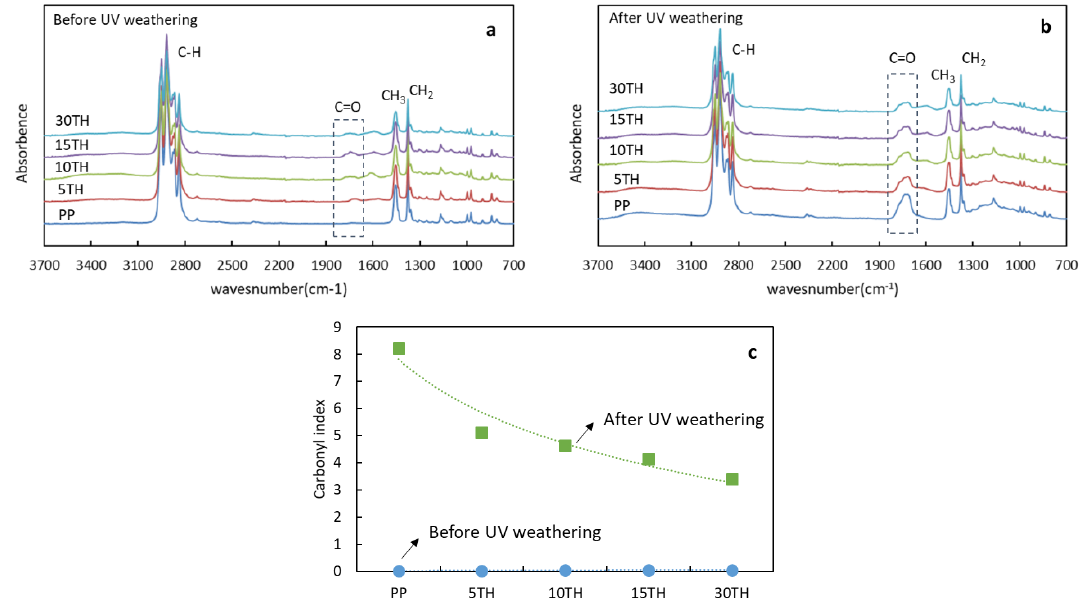
Figure 8. ( a ) FTIR spectra of PP and PP/TH composite before UV weathering ( a ); after UV weathering ( b ) and their carbonyl index ( c ).